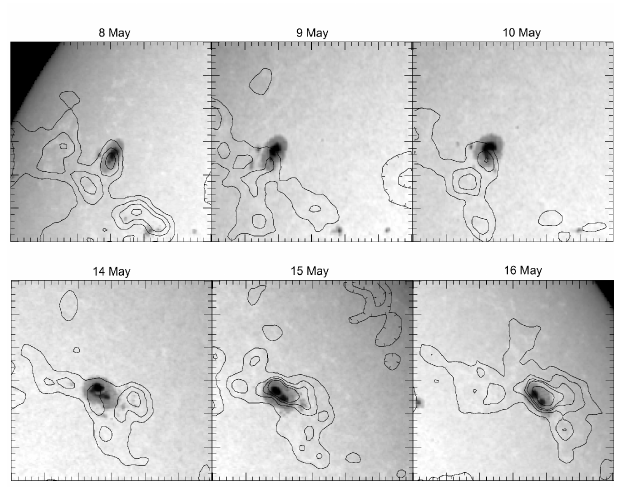
Fig. 4. Total intensity (Stokes I) contour maps of 17 GHz images (NoRH) overlaid on white-light images (SOHO MDI continuum). The brightness temperature T B are as follows: 0.9, 1 (downhill line), 1.5, 2, 2.5, 3, and 5 (solid line) in units of 10 4